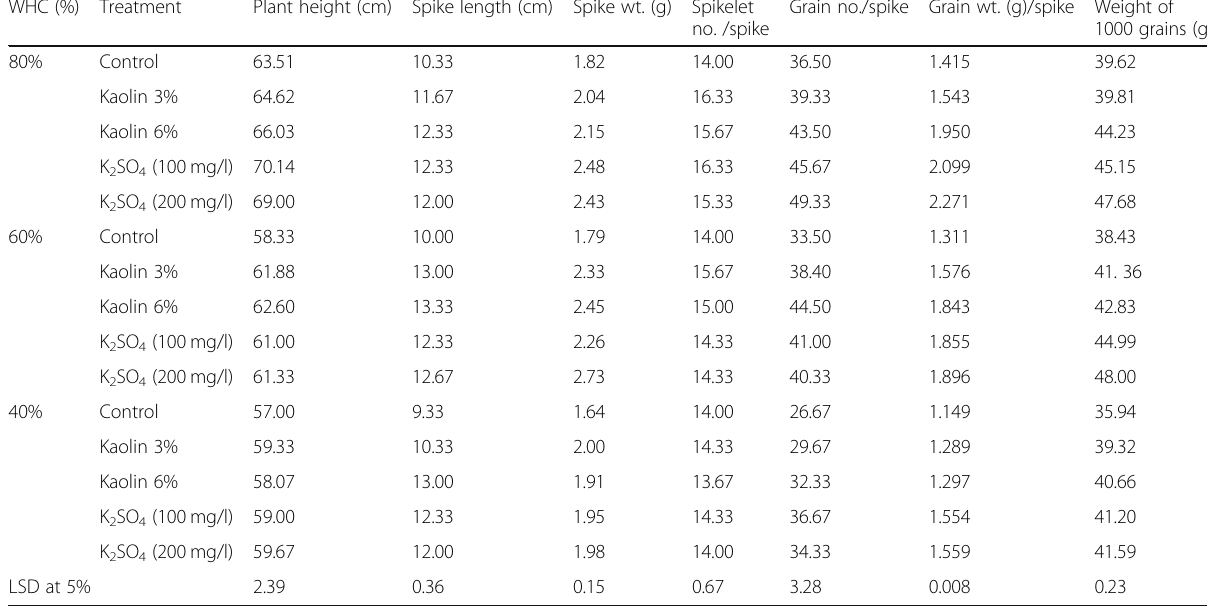
Table 7 Effect of different concentrations of kaolin or K 2 SO 4 under different levels of water holding capacity on yield components of wheat plants (combined analysis of two seasons)